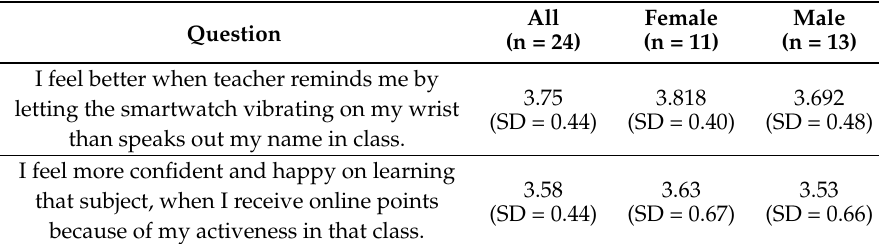
Table 6. Some key responses split by student